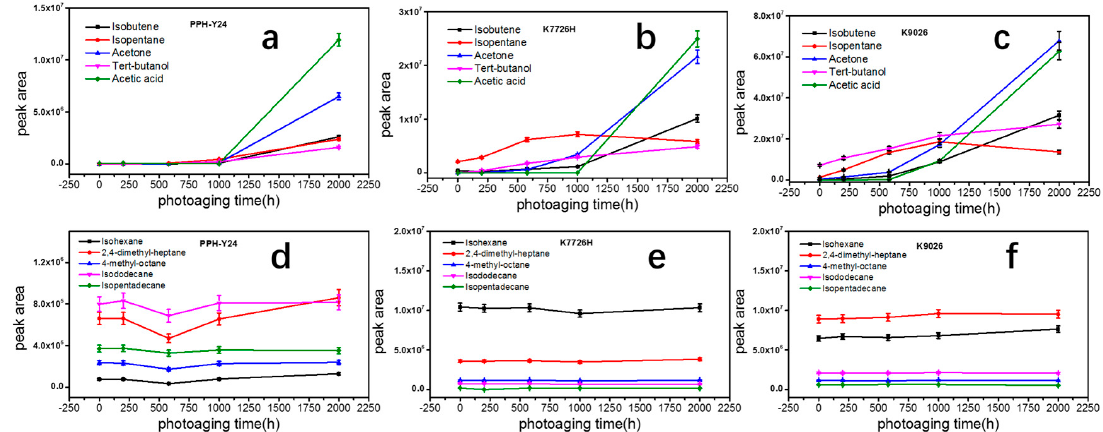
Figure 4. Peaks areas of different VOCs from PP resins after photoaging at different periods ( a ) and ( d ), PPH-Y24; ( b ) and ( e ), K7726H; ( c ) and ( f ), K9026).